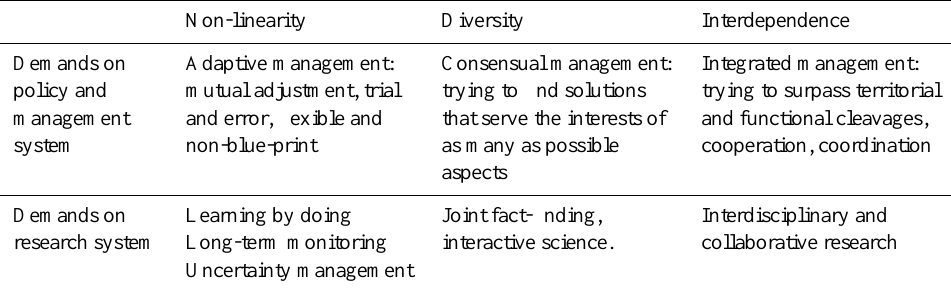
Table 2. Demands on the policy/management and research system.